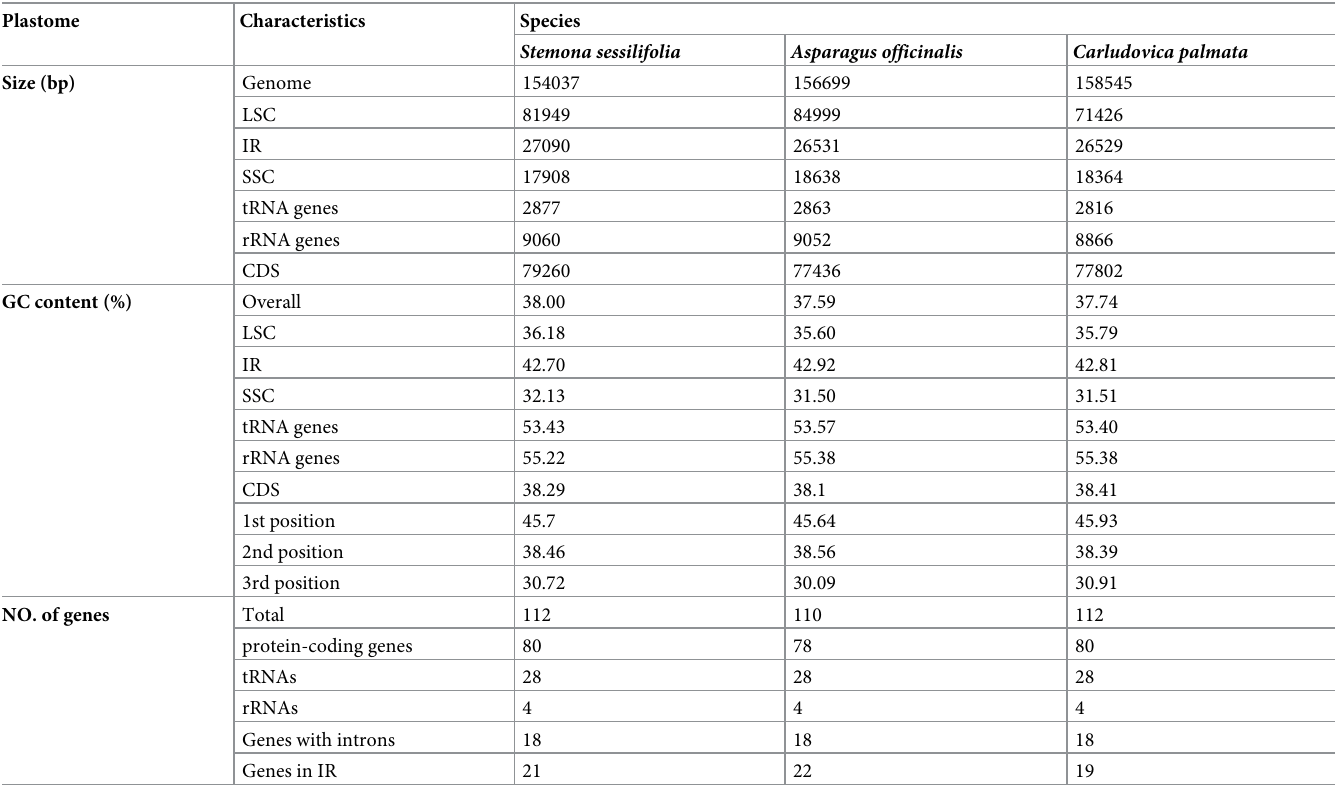
Table 1. Chloroplast genome characteristics of Stemona sessilifolia , Asparagus officinalis and Carludovica palmata .